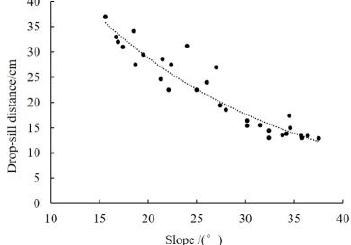
Figure 7 Relationship between drop-sill distance and slope in ephemeral gully channel (Xu et al.,